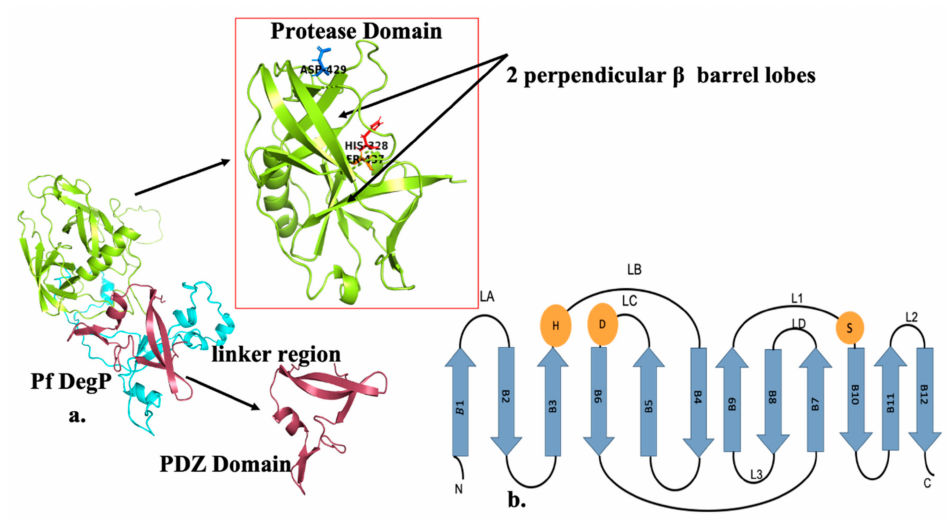
Figure 1. ( a ) Domain organisation and representation of PfDegP protein: Domain architecture of DegP consists of three distinct domains which include an N-terminal region known to have regulatory functions, a conserved trypsin-like protease domain (PD) shown in lemon having two perpendicular β barrel lobes and along with the catalytic triad displayed as sticks: Histidine (His 328) shown in red color, Aspartate (Asp 429) shown in marine, Serine (Ser 437) depicted in orange, Linker Region shown in cyan and one PDZ domain in brick red ( b ) Secondary structure elements of the DegP protease domain. The protease domain depicts a chymotrypsin fold and the B strands (shown as arrows) forming N and C terminal B barrels. For the sake of simplicity, the alpha helices are not depicted here. Catalytic triad residues: H, D and S are shown as orange spheres. Based on the chymotrypsin nomenclature, the loops of the protease domain are named, loops LD, L1, L2 and L3 shown in the figure are known to be